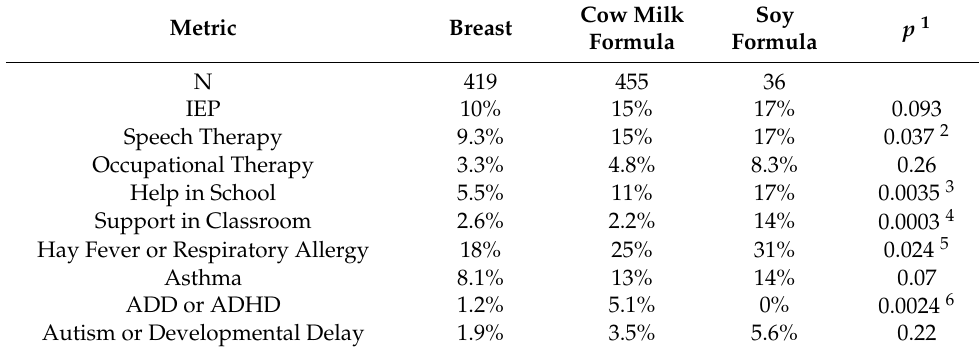
Cow Milk Soy p 1 Formula Formula